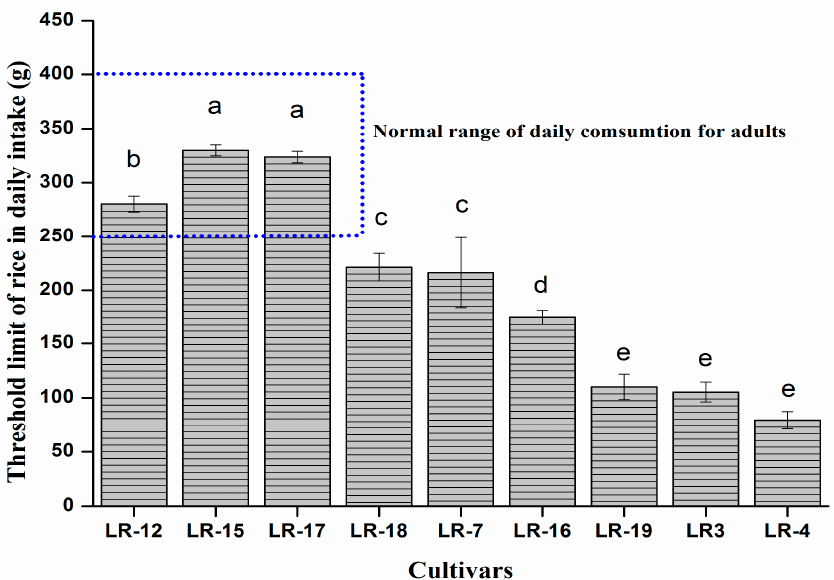
Table 2. Grain Cd concentration, grain yield and mineral nutrient concentration in polished rice of cultivars in the 2nd year experiment. Data are means of three replicates; followed by different letters indicate significant difference p < 0.05. MID and HIGH represent medium and high Cd accumulation cultivars in the first-year experiment.